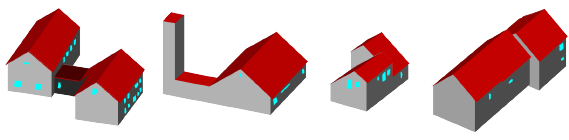
Figure 7. Buildings with windows as CityGML objects Texture mapping on the four buildings exposed more than 100 image candidates for each polygon due to the highly overlapping flight pattern. In the end a maximum of 15 bitmaps has been kept after the visibility test and redundancy removal. The worst- case GSD on the polygons ranges from 5 to 11 cm depending on the surface slope and building orientation on the ground